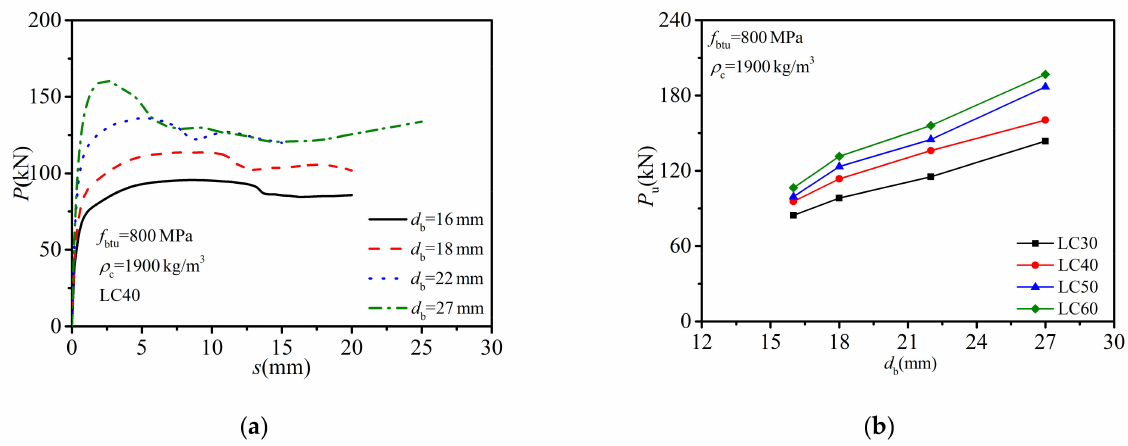
Figure 16. Influence of bolt diameter ( d b ): ( a ) force-slip relationship; ( b ) shear